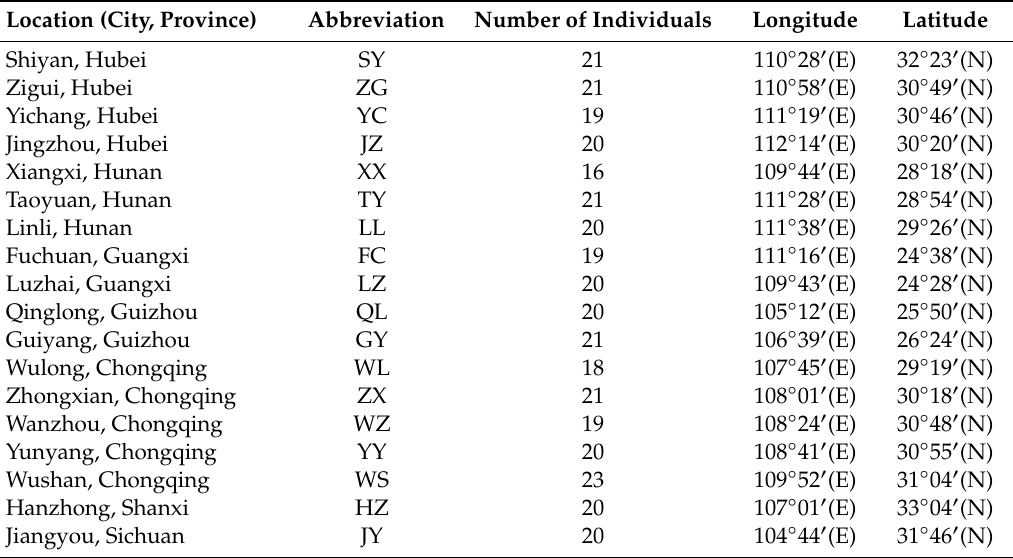
Table 1. Sampling information of Bactrocera minax